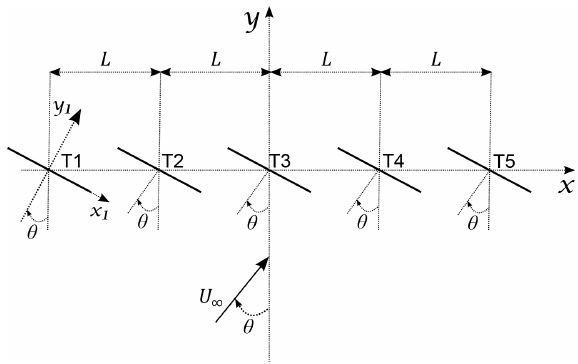
Figure 1. Schematics of the wind turbine rotors (T1–T5) in the numerical setup. Clockwise relative directions of θ are